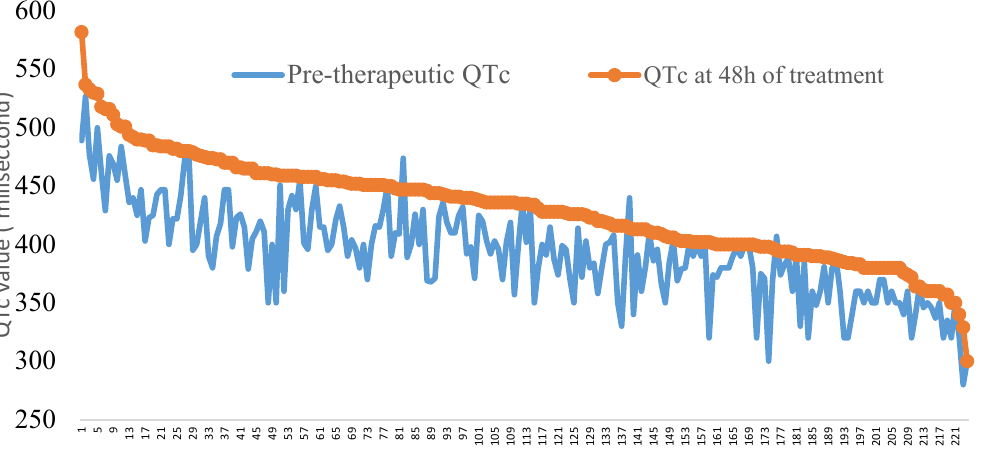
Figure 1. Representations of QTc values at baseline and after 48 h of treatment with hydroxychloroquine or chloroquine in 224 COVID-19 patients.